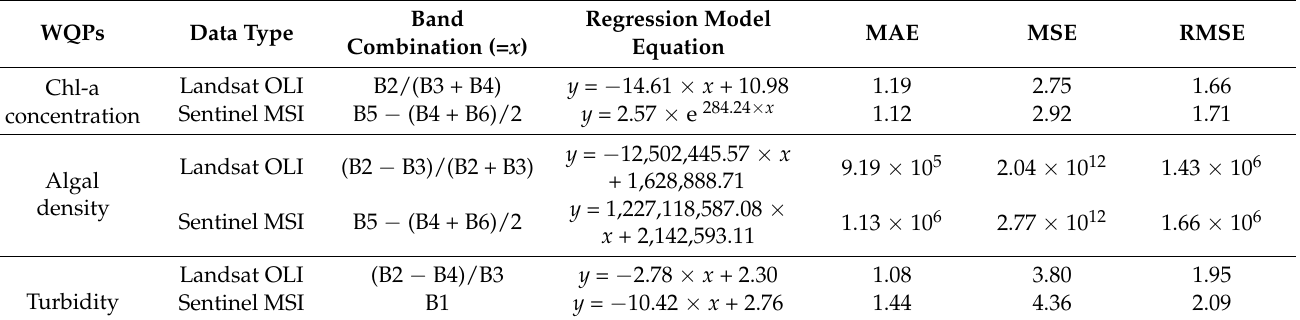
Table 13. Comparison of evaluation indexes of WQPs regression formula (brought into training and testing dataset